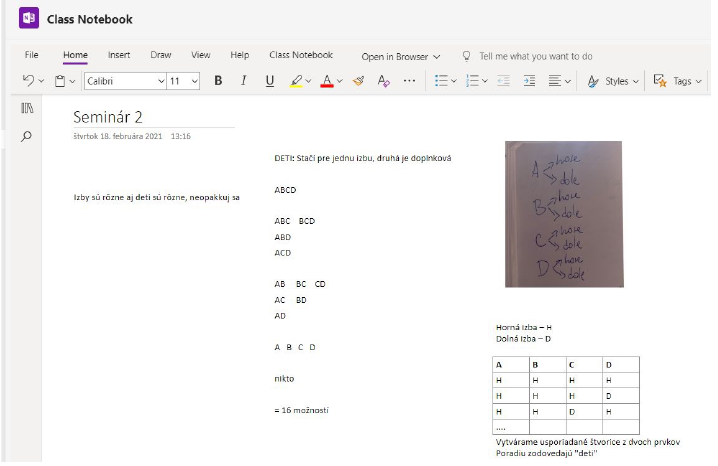
Figure 5. Part of Collaboration Space with contributions of four PSTs.